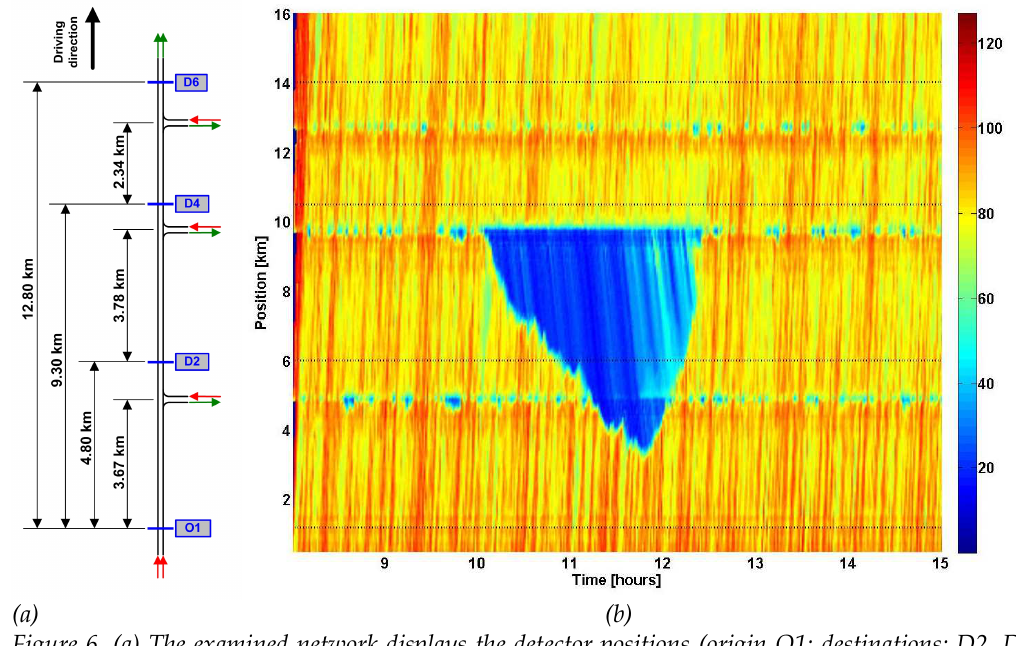
Figure 6. (a) The examined network displays the detector positions (origin O1; destinations: D2, D4 and D6) together with the relevant distances. (b) Time-space view of the average speed (over both lanes) for scenario 1 and the whole simulation